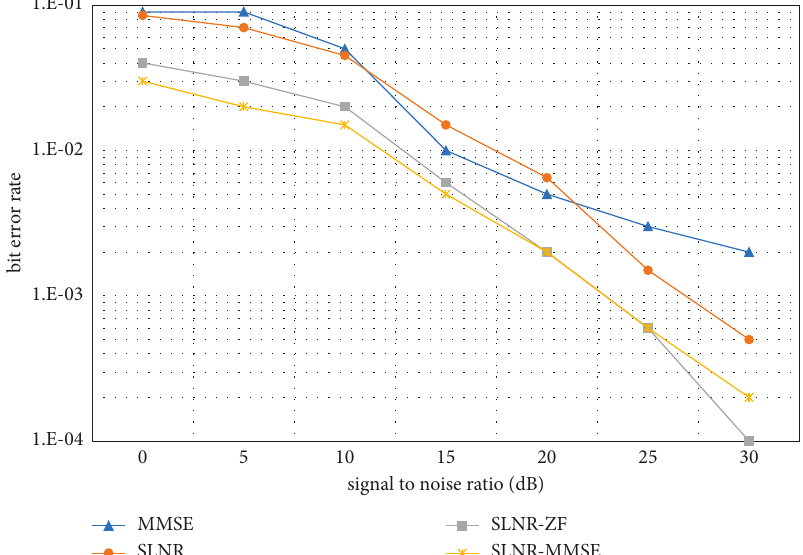
Figure 6: Bit error rate before and after the improvement of the SLNR precoding algorithm when the antenna configuration is 3